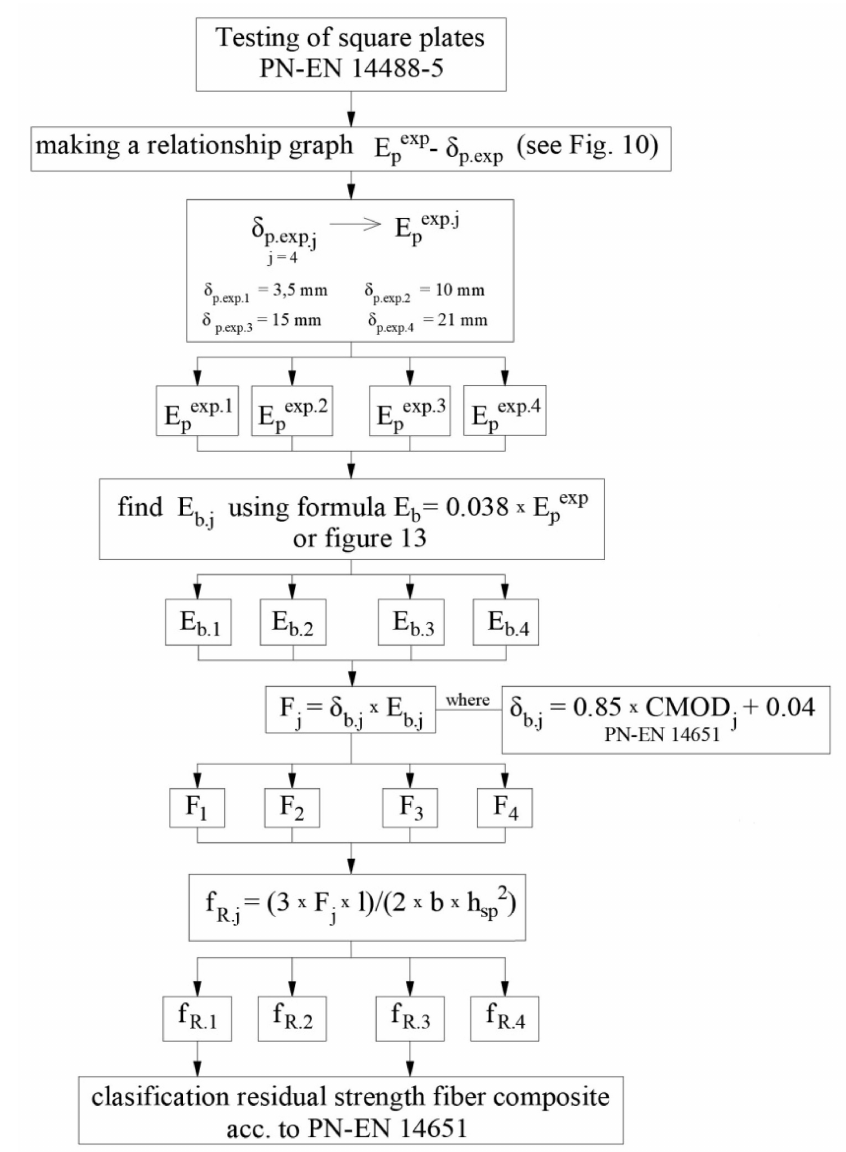
Figure 14. Procedure for determining the residual strength for the fiber